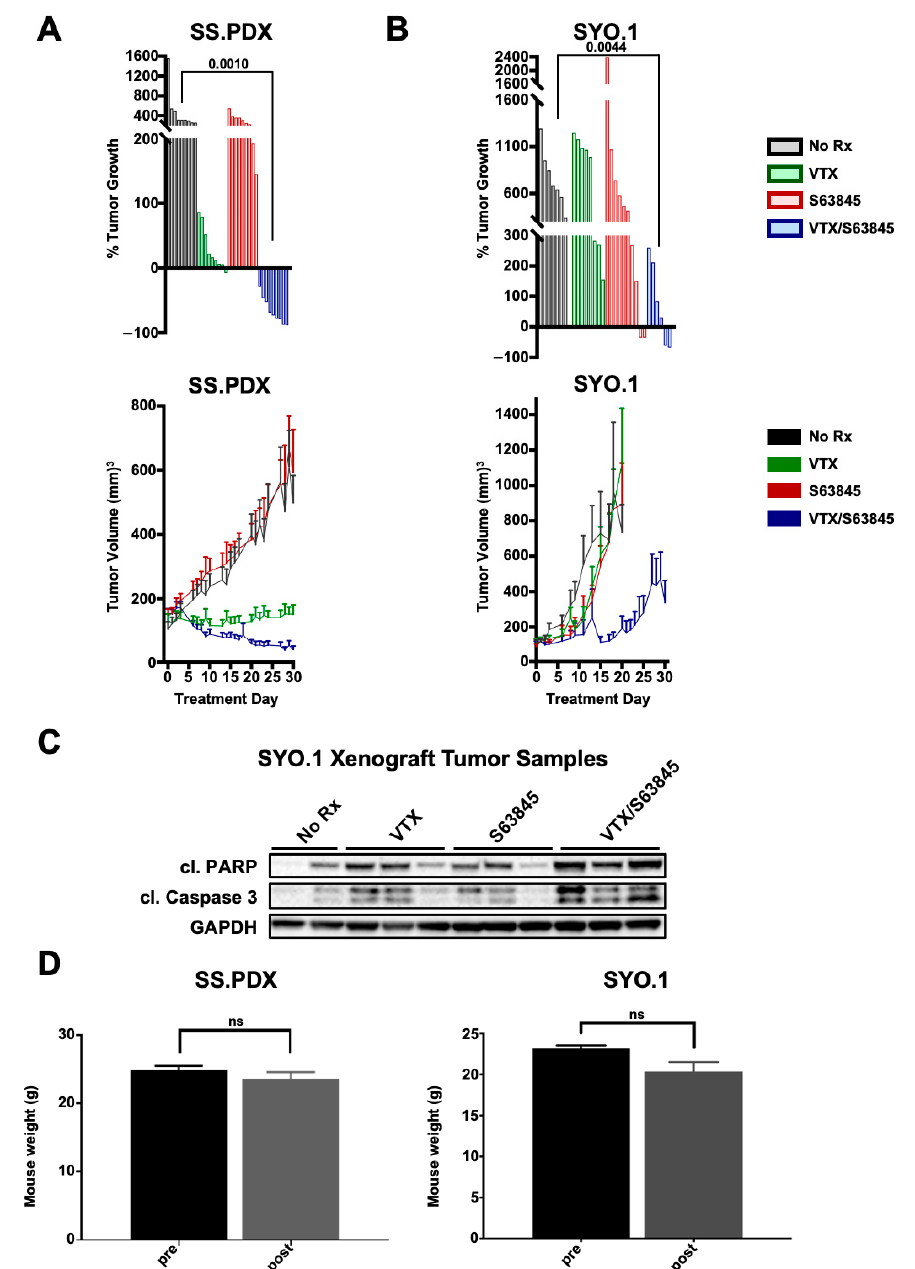
Figure 5. Venetoclax and S63845 combine to inhibit tumor growth in vivo. Mice were injected with 5 × 10 6 cells from a patient-derived xenograft model of SS ( A ) or from the SYO.1 cell line model ( B ) to generate tumors. Tumor size was measured by caliper and tumor volume calculated by L*W 2 *.52. As tumors approached a volume of approximately 150 mm 3 , mice were randomized to no treatment, VTX, S63845, or a combination of both drugs. Mice in the VTX and combination groups received daily 100 mg/kg VTX orally for four weeks. S63845 and combination groups received 25 mg/kg S63845 IV daily on weeks 1 and 3, with a treatment holiday on weeks 2 and 4. (( A , B ) (top)): Waterfall plot showing change in tumor volume of no treatment (black), VTX (green), S63845 (red), and combination (blue) groups. Each bar represents an individual tumor. For SS.PDX, initial tumor sizes were compared to final tumor volume after 30-day treatment. Because SYO.1 tumors tended to grow much faster, initial volume was compared to tumor volume after 20 days. ( A , B ) p values, indicated on graph, were calculated using Student’s t -test. (bottom): Average change in tumor growth over time. Error bars indicate SEM. ( C ) Western blot analysis of apoptotic markers cleaved PARP1 and cleaved caspase 3. Representative tumor lysates from no treatment, VTX, S63845, and combination groups are displayed. ( D ) Neither SS.PDX nor SYO.1 combination groups showed a significant decrease in weight over the treatment